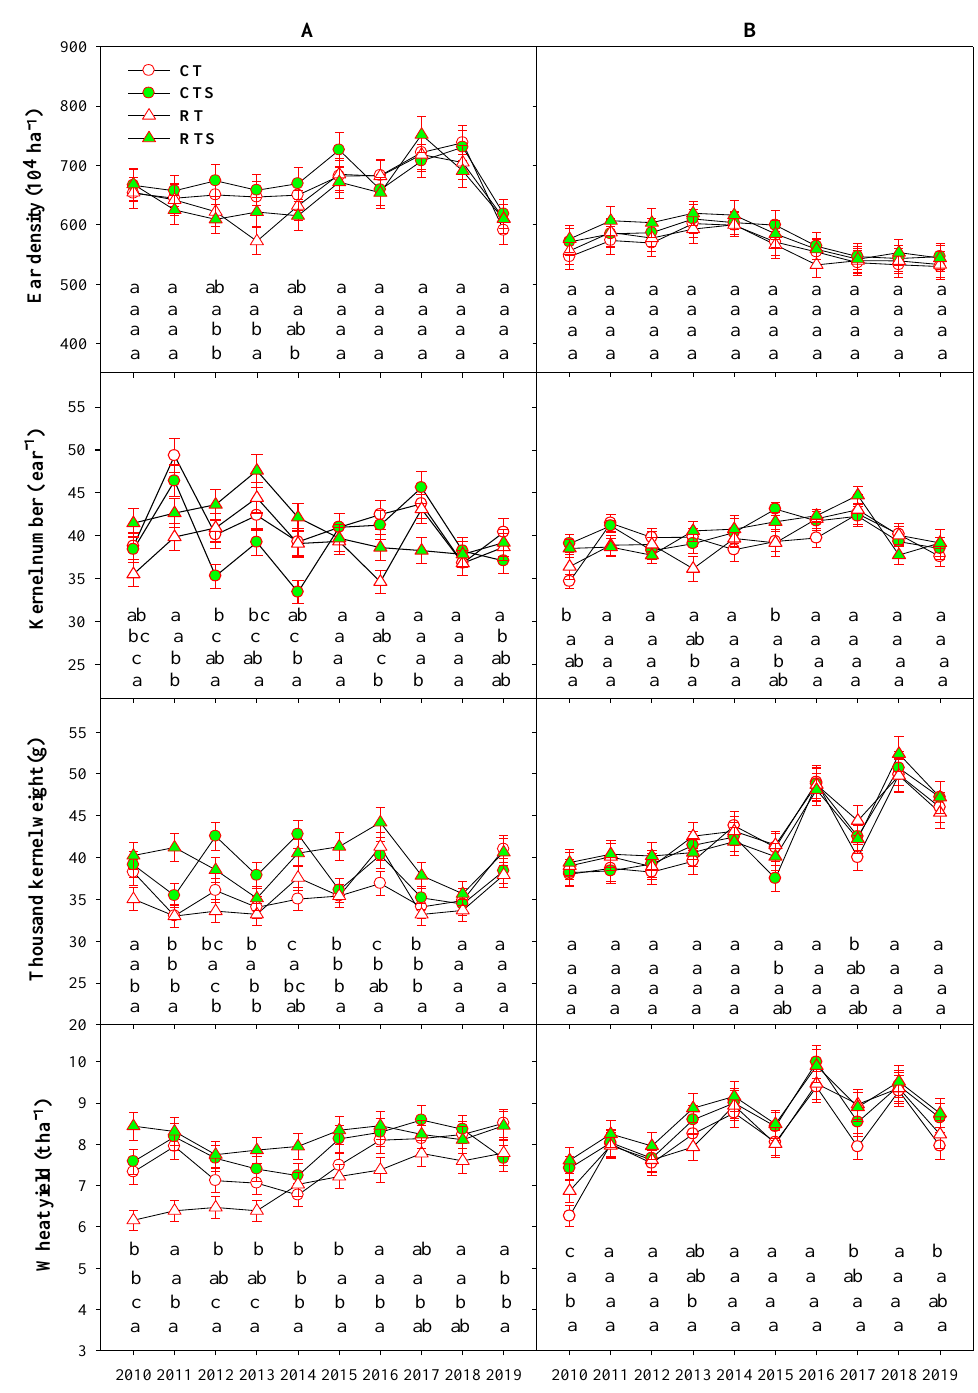
Figure 3. Wheat yield and yield components over time under tillage and straw returning practices at the Tai’an ( A ) and Longkou ( B ) experimental sites. CT: conventional tillage without straw returning; CTS: conventional tillage with straw returning; RT: rotary tillage without straw returning; RTS: rotary tillage with straw returning. T-like lines: standard deviation. Different letters in each column indicate significant differences between different treatments ( p < 0.05 ; Duncan’s test).